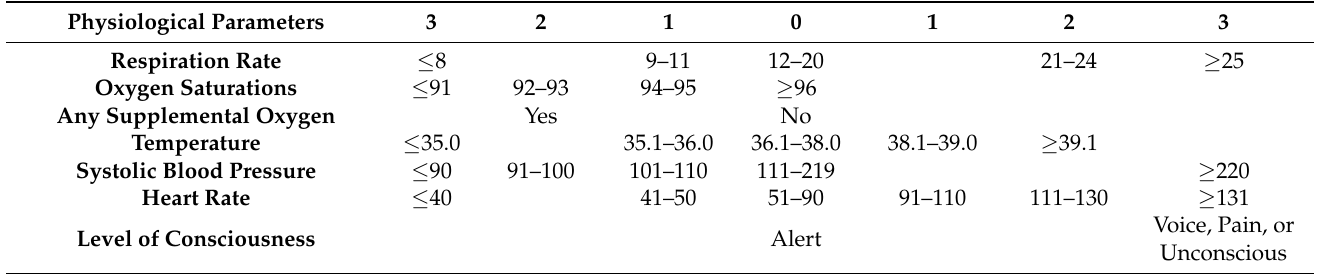
Table 5. The strategy to estimate national early warning score (NEWS).